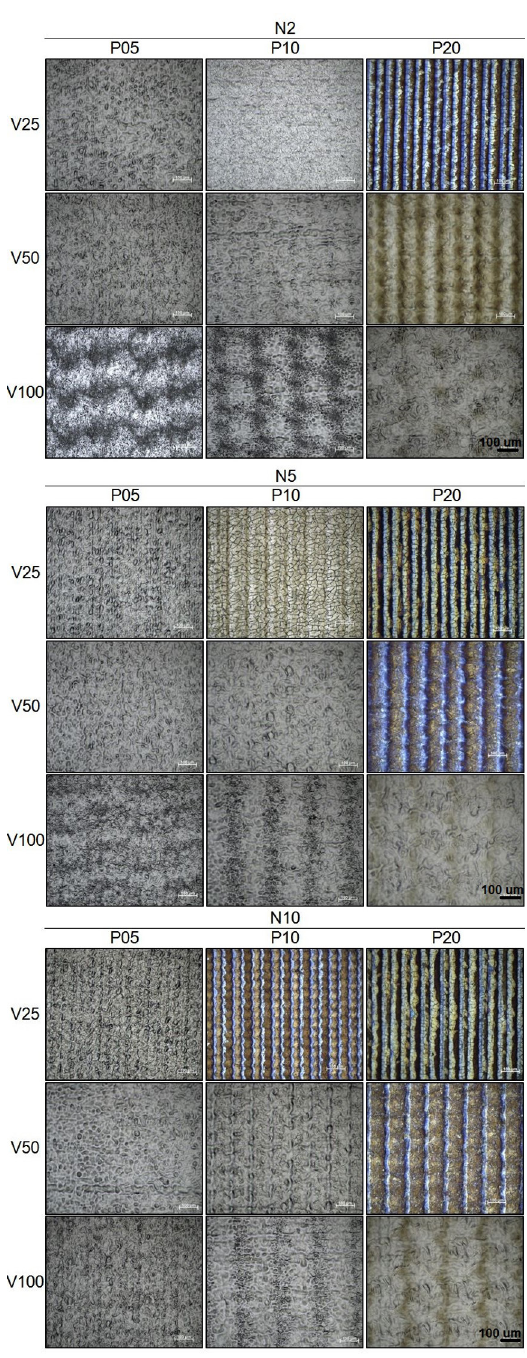
Figure 3. Evolution of the surface topography for N2, N5 and N10 using different power (P) and speed (V). The scales are the same.